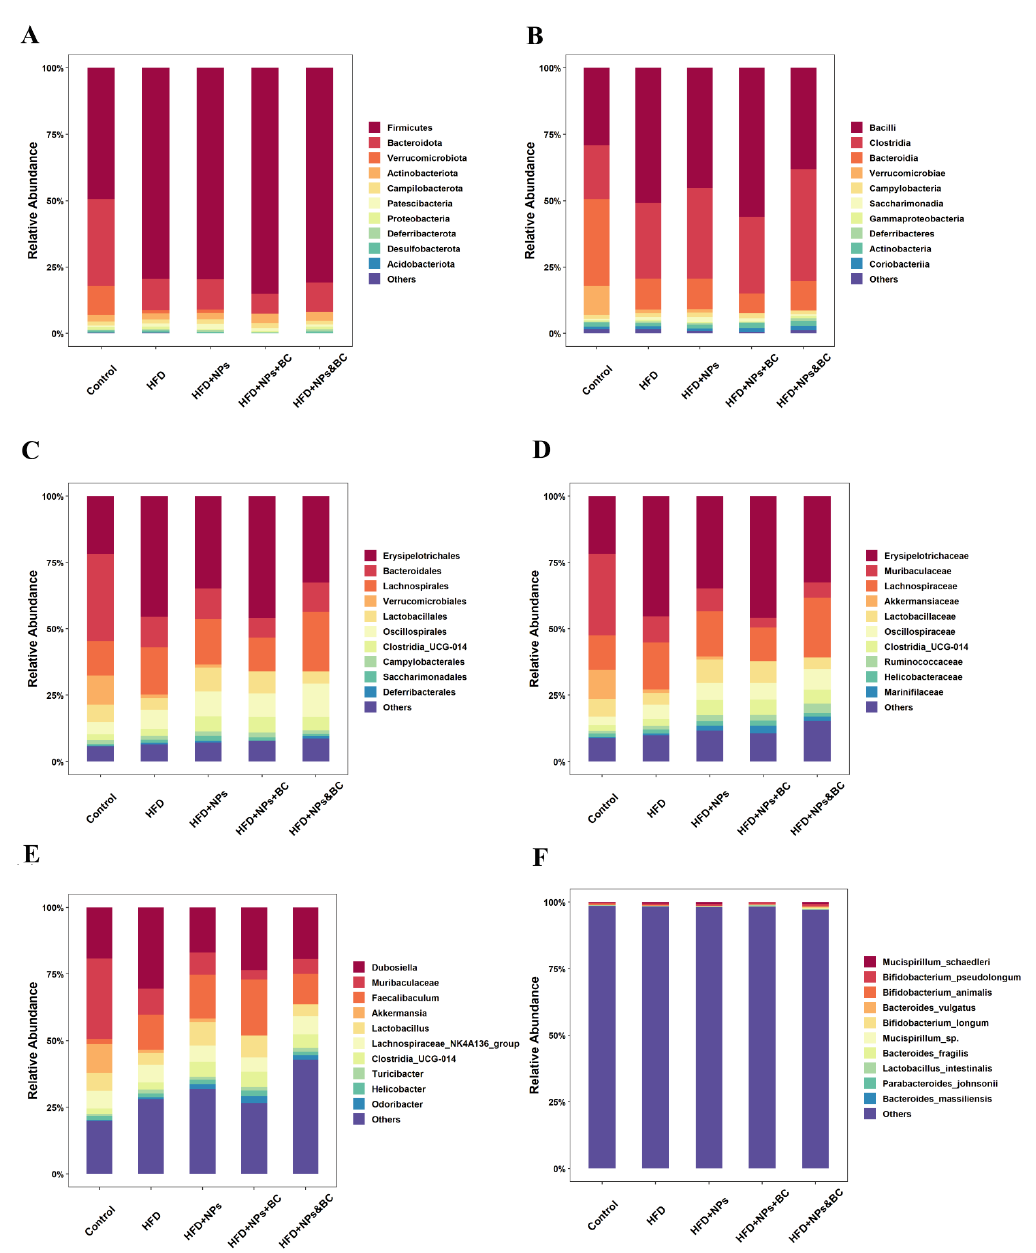
Figure 5. Distribution of bacterial groups at different taxonomic levels. ( A ) Phylum level, ( B ) class level, ( C ) order level, ( D ) family level, ( E ) genus level, and ( F ) species level. At the phylum level, the dominant intestinal bacteria in mice in the five groups were Firmicutes and Bacteroidetes. The proportion of the two dominant bacteria in the control